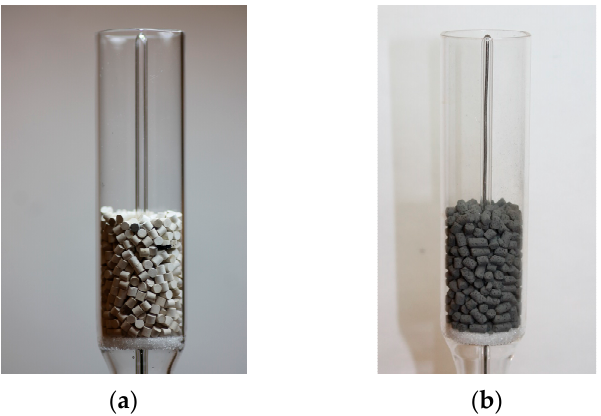
Figure 13. Catalysts in reactors before the experiments. ( a ) Rhodium; ( b ) nickel. A thermoelement pocket runs through the catalyst bed. Table 3. Operating conditions of each test run. Ni1 refers to commercial nickel catalyst, Ni2 to in-house nickel